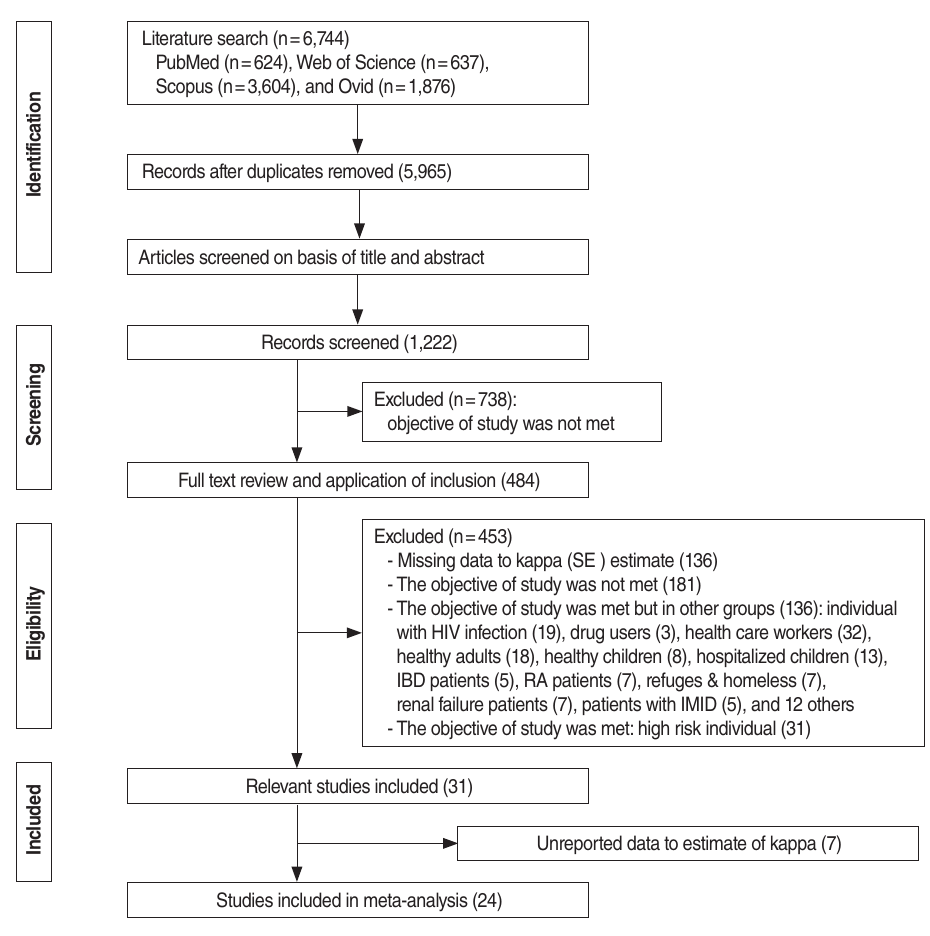
Figure 1. The flow chart of retrieve studies into meta-analysis. SE, standard error; IBD, Inflammatory Bowel Disease; RA, Rheumatoid Arthri- tis; IMID, Immune-Mediated Inflammatory